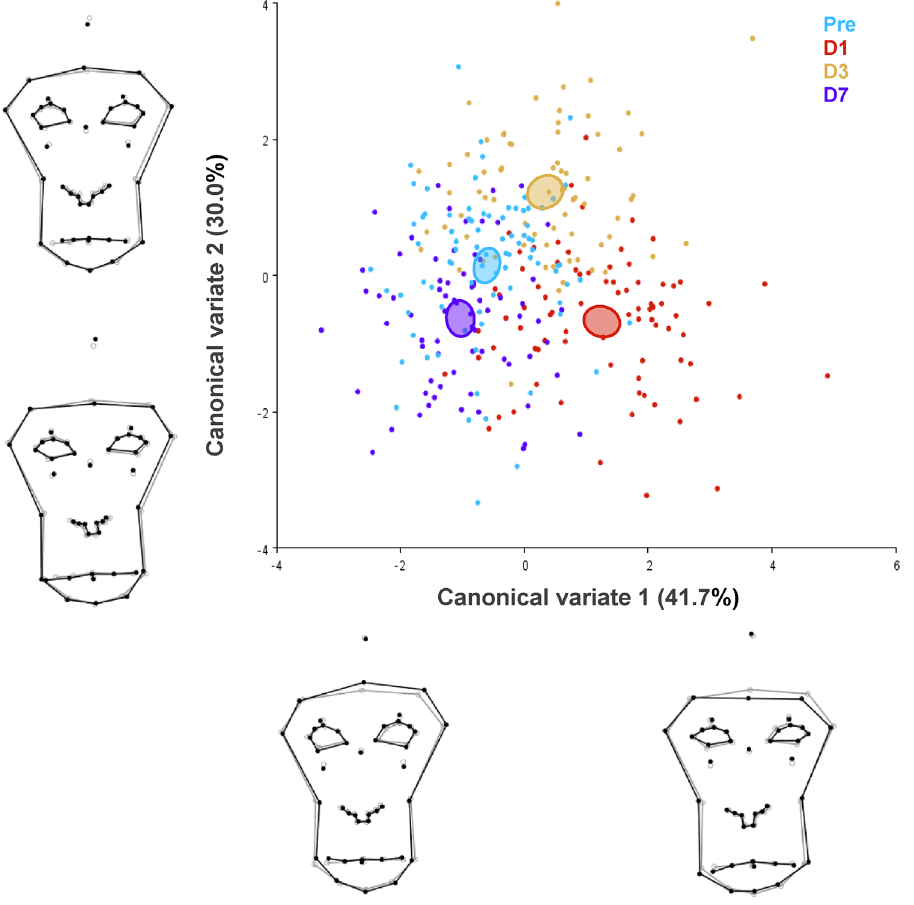
Figure 3. Facial shape variation between conditions after Canonical Variate Analysis. Each colour refers to one condition and confidence ellipses for means are given with probability of 0.9. The wireframes depict changes in shape along the two main canonical variates (black: variation per unit of within-subject variation (Mahalanobis distances) relative to the grey-mean shape. The amount of variation explained by each CV is shown in